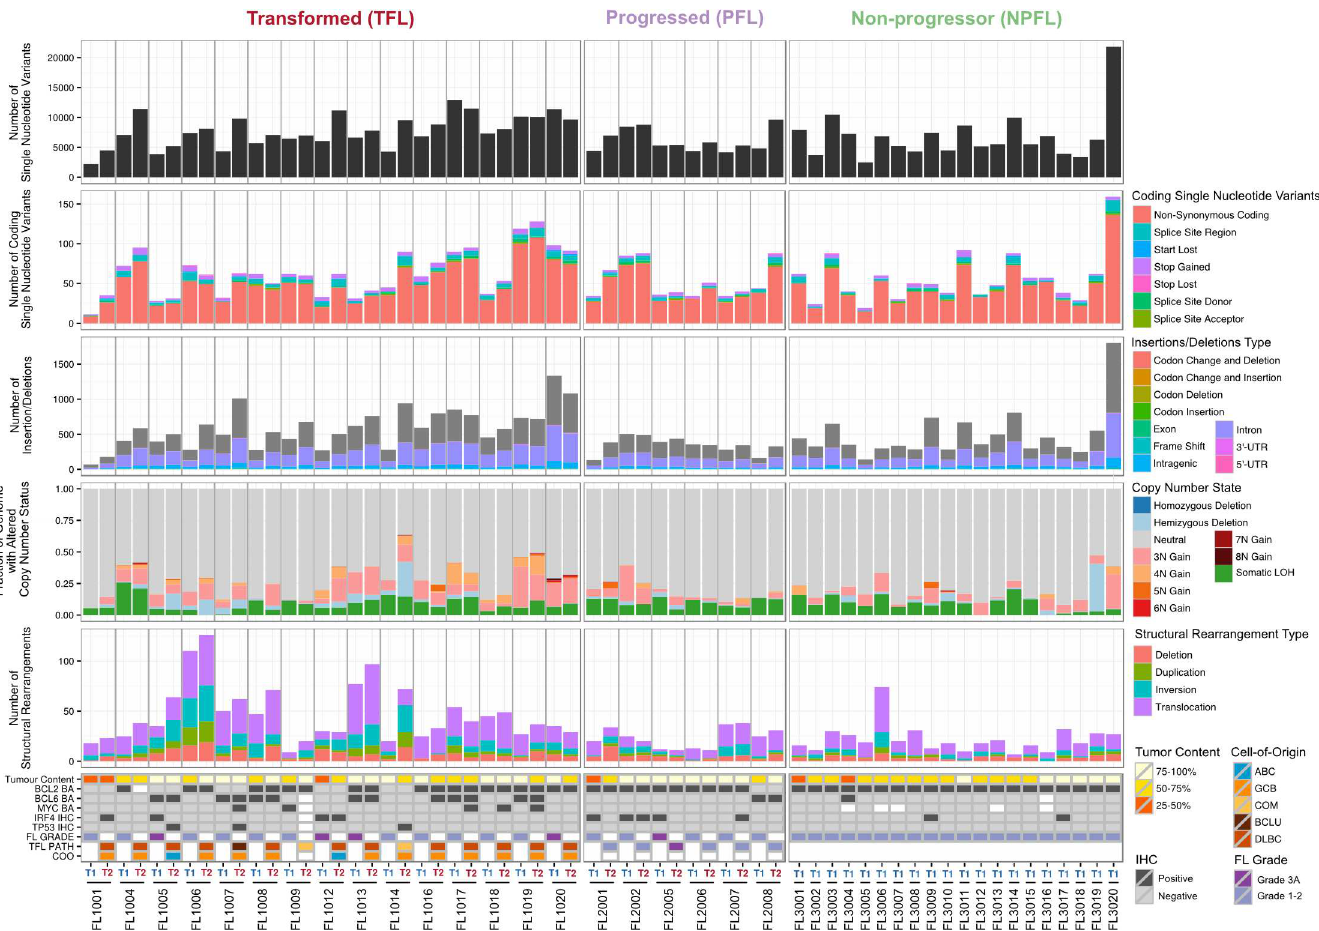
Fig 2. High-level WGS analysis overview. Number of genomicalterationsby sample and by clinicalgroup. For the TFL and PFL patients, the T1 and T2 sample are placedbeside each other. Each panel represents a different mutation type (sSNV, sIndel, sCNA, structural rearrangement), with the number of mutations on the y -axes. Different colors represent the different categoriesof mutationswithin each mutation type. For sCNAs, the fraction of genome altered is plotted and copy numberstates are mutually exclusive. The somatic LOH class encapsulates all LOH events regardlessof their absolute sCNA state (3N, 4N, etc.). Refer to S3 Table for more details on copy number state annotations. ABC, activated B-cell-like;BCLU, B cell lymphoma unclassified; COM, composite lymphoma; DLBC, diffuse large B cell lymphoma; FL, follicularlymphoma; GCB, germinalcenter B-cell-like; IHC,